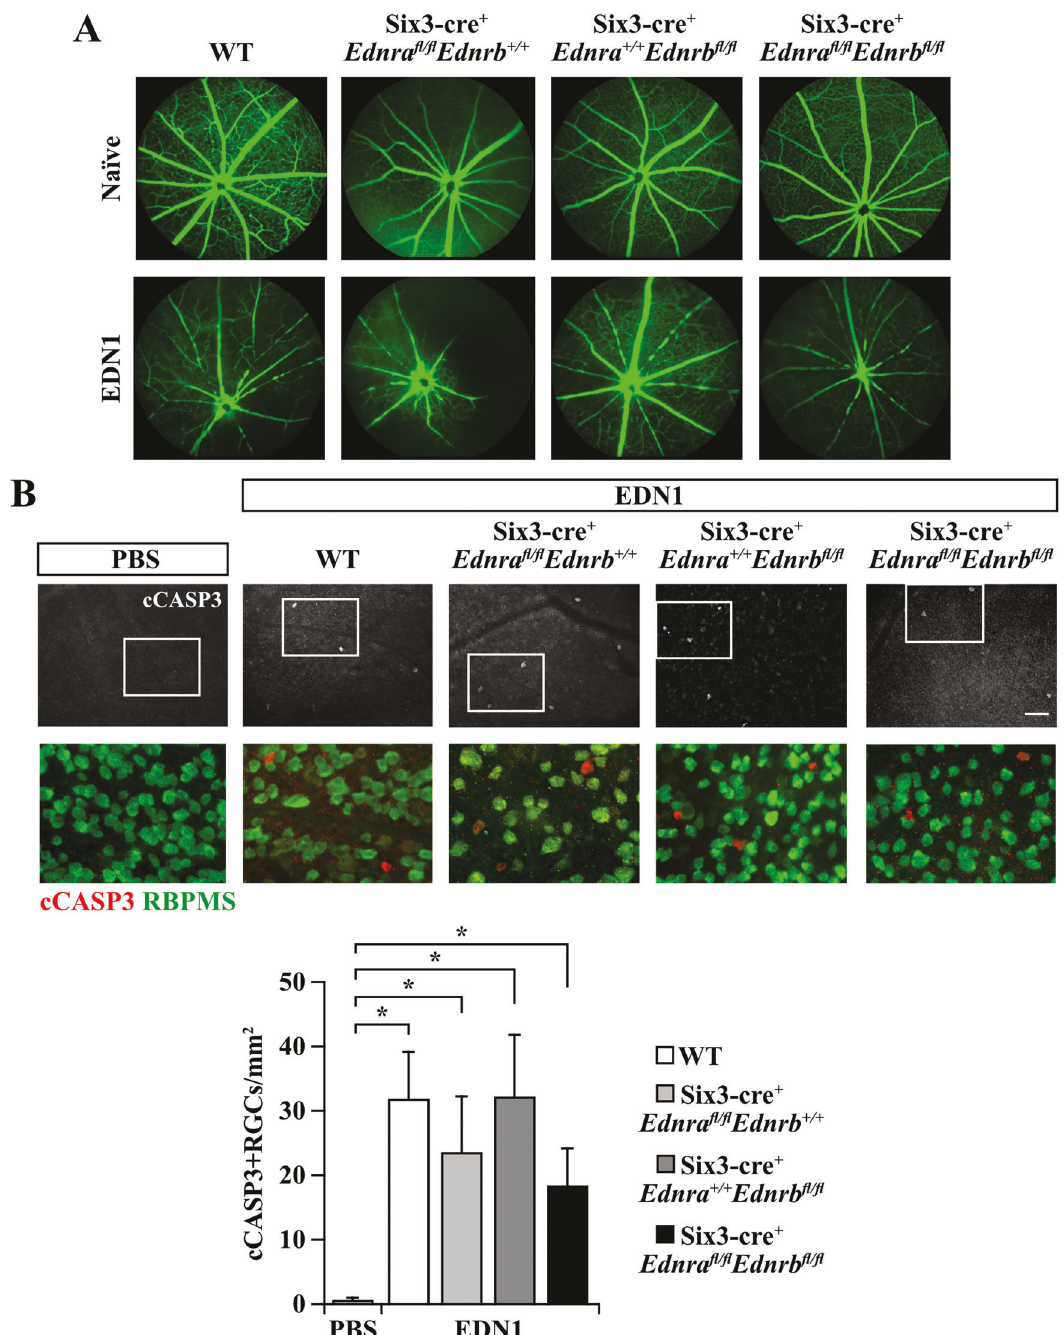
Fig. 1 EDN1 did not cause RGC death directly or via macroglia-expressed receptors. A Fluorescein angiography of retinal vasculature in naive and EDN1-injected eyes from WT, Six3-cre + Ednra fl / fl Ednrb + / + , Six3-cre + Ednra + / + Ednrb fl / fl , and Six3-cre + Ednra fl / fl Ednrb fl / fl animals. Deletion of either or both Edn receptors with Six3-cre did not prevent EDN1-induced vasoconstriction ( n ≥ 3). B Retinal fl at mounts and quanti fi cation of cleaved caspase 3 + (cCASP3 + , red) RBPMS + (green) cells from WT, Six3-cre + Ednra + / + Ednrb fl / fl , Six3-cre + Ednra fl / fl Ednrb + / + , Six3-cre + Ednra fl / fl Ednrb fl / fl 5 days post-EDN1 or PBS (vehicle control) injection. Each genotype group had signi fi cant increases in cCASP3 + RGCs compared to PBS controls. No signi fi cant difference in cCASP3 + RGCs was observed between genotype groups after EDN1. cCASP3 + RGCs/mm 2 ± SEM: PBS: 0.8 ± 0.3, WT: 32.0 ± 7.2, Six3-cre + Ednra fl / fl Ednrb + / + : 23.7 ± 8.6, Six3-cre + Ednra + / + Ednrb fl / fl : 32.3 ± 9.5, Six3-cre + Ednra fl / fl Ednrb fl / fl : 19.8 ± 6.0 ( n ≥ 7 per genotype, * P < 0.05, Kruskal – Wallis test). Scale bars, 50 μ mural cells. To determine whether EDN acts through vascular mural distinct branching pattern compared to retinal veins [53]) and cell-expressed EDNRA to cause RGC death, EDN1 ligand was capillaries in super fi cial, intermediate, and deep layers of the retina. intravitreally injected into Myh11-creER T2 + Ednra fl / fl mice. Mural cell Importantly, EDN1-induced vasoconstriction was attenuated in Myh11-creER T2 + Ednra fl / fl retinas (Fig. 4D). Therefore, Ednra fl alleles deletion of Ednra prevented caspase 3 activation in RGCs 5 days after EDN1 (Fig. 5A), and prevented RGC loss after 28 days (Fig. 5B). were speci fi cally and ef fi ciently recombined from retinal vascular